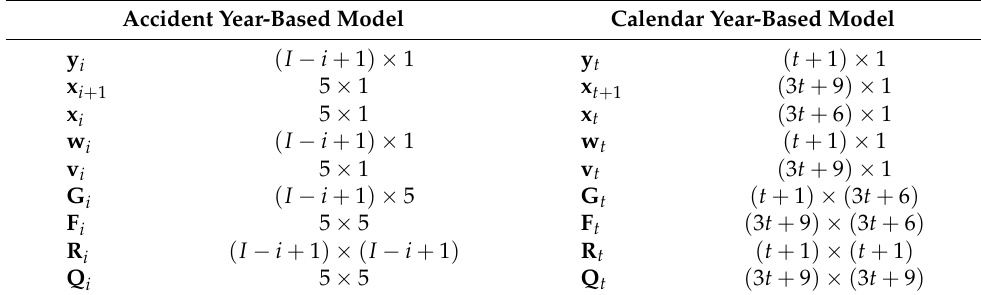
Table 2. Dimensions in the state space models of Taylor et al.